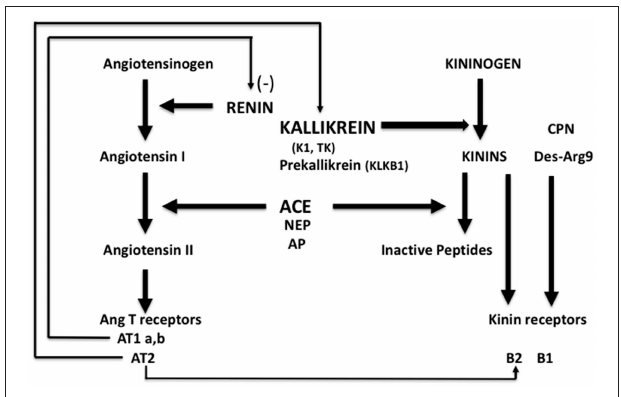
FIGURE 1 | Schematic representation of the renin-angiotensin and kallikrein-kinin systems with physiological interrelation. ACE, angiotensin-converting enzyme/kininase II; NEP, neutral-endopeptidase; AP, aminopeptidase P; CPN, carboxypeptidase